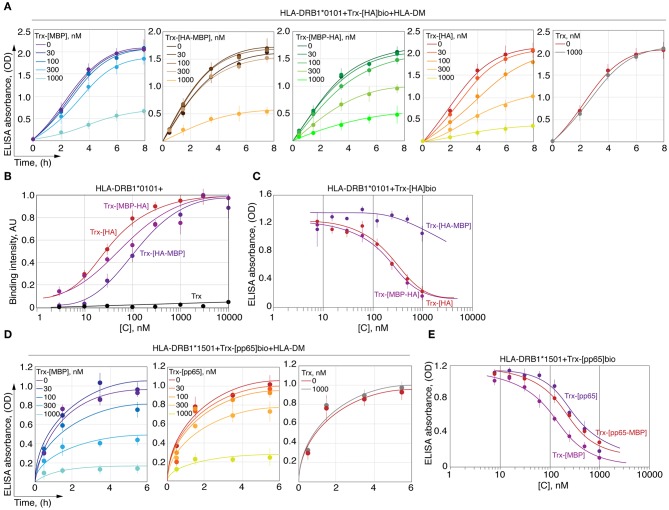
HA peptide prevents loading of MBP146−170 onto the HLA-DRB1*01:01. (A) Recombinant HLA-DRB1*01:01 (150 nM) and HLA-DM (150 nM) were incubated with biotinylated thioredoxin-fused HA306−318 (Trx-[HA]bio) (150 nM) in the presence of increasing concentrations (0-1 μM) of thioredoxin-fused MBP151−164 (Trx-[MBP]), HA306−311-MBP157−164 (Trx-[HA-MBP]), MBP151−156-HA312−318 (Trx-[MBP-HA]) and HA306−318 (Trx-[HA]). Thioredoxin (Trx) without any peptide was used as a control. At indicated timepoints 8, 6, 4, 2, and 0 h, the amount of bound Trx-[HA]bio was determined by addition of streptavidin-HRP. (B) Binding of thioredoxin fusions containing HA306−318 (red) and chimeric peptides assembled from N- and C-terminal parts of HA306−318 and MBP151−164 (Trx-[MBP-HA] and Trx-[HA-MBP]) in different concentrations (3 nM−10 μM) with recombinant HLA-DRB1*01:01 (5 nM) measured by DELFIA with time-resolved fluorescence detection. (C) Recombinant HLA-DRB1*01:01 (150 nM) was incubated with biotinylated thioredoxin-fused HA306−318 (Trx-[HA]bio) (150 nM) in the presence of increasing concentrations (7.8 nM−1 μM) of thioredoxin-fused HA306−318 (Trx-[HA]) and chimeric peptides assembled from N- and C-terminal parts of HA306−318 and MBP151−164 (Trx-[MBP-HA] and Trx-[HA-MBP]). After 18 h of incubation, the amount of bound Trx-[HA]bio was determined by addition of streptavidin-HRP. (D) Recombinant HLA-DRB1*15:01 (150 nM) and HLA-DM (150 nM) were incubated with biotinylated thioredoxin-fused pp65109−123 (Trx-[pp65]bio) (150 nM) in the presence of increasing concentrations (0-1 μM) of thioredoxin-fused MBP85−97 (Trx-[MBP]), pp65109−114-MBP91−97 (Trx-[pp65-MBP]), and pp65109−123 (Trx-[pp65]). Thioredoxin (Trx) without any peptide was used as a control. At indicated timepoints 5.5, 3.5, 1.5, and 0.5 h, the amount of bound Trx-[pp65]bio was determined by addition of streptavidin-HRP. (E) Recombinant HLA-DRB1*15:01 (150 nM) was incubated with biotinylated thioredoxin-fused pp65109−123 (Trx-[pp65]bio) (150 nM) in the presence of increasing concentrations (7.8 nM−1 μM) of thioredoxin-fused MBP85−97 (Trx-[MBP]), pp65109−114-MBP91−97 (Trx-[pp65-MBP]), and pp65109−123 (Trx-[pp65]). After 18 h of incubation, the amount of bound Trx-[pp65]bio was determined by addition of streptavidin-HRP.